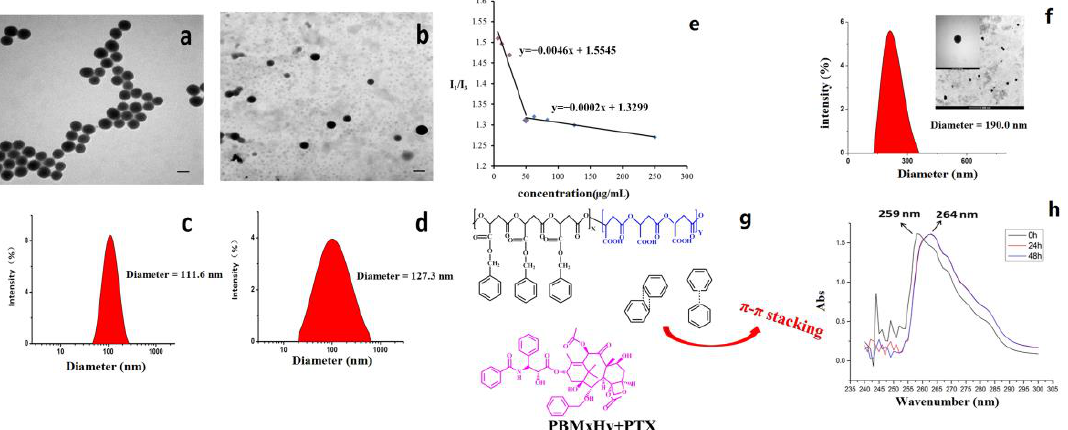
Figure 9. DLS and TEM results of partially hydrogenolyzed PBM micelles. The scale bar is 100 nm. ( a , c ) PBM 23 H 77 ; ( b , d ) PBM 17 H 83 ; ( e ) CMC value of PBM 23 H 77 micelle; ( f ) PBM 23 H 77 @PTX; ( g ) schematic diagram of π - π stacking between PBM and PTX; ( h ) migration of UV absorption curve before and after π - π stacking PBM 23 H 77 @PTX).